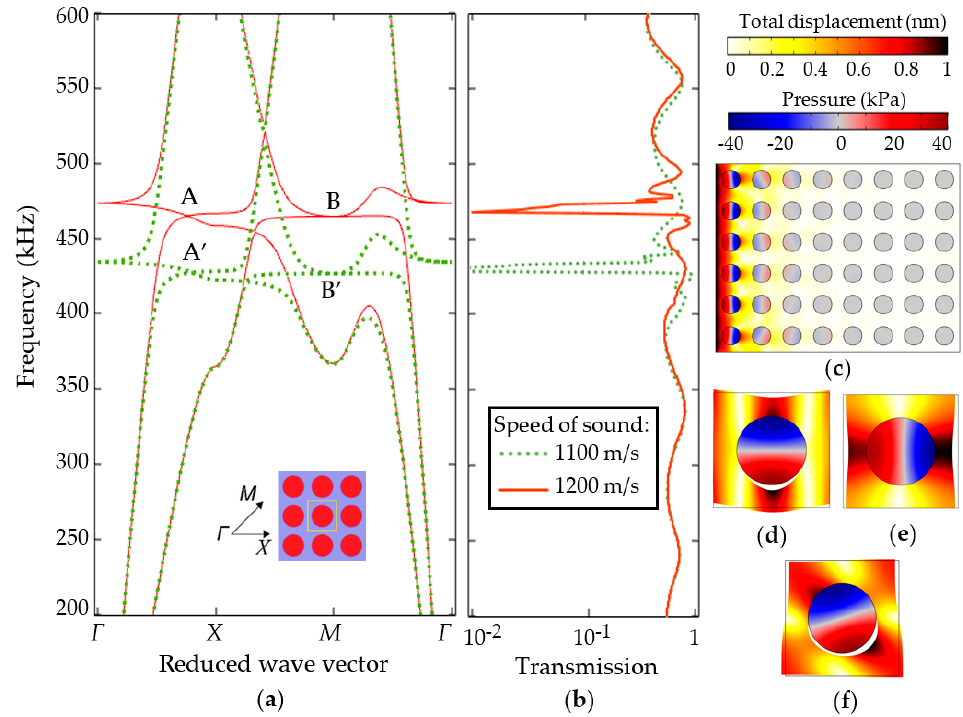
Figure 6. Theoretical description of the second type solid-liquid periodic composite sensor structure: ( a ) Band diagram for the 2D cubic infinite structure made of steel with periodic cylindrical liquid-filled holes computed for two different sound velocities in liquid (green dotted and red solid curves); ( b ) transmission spectrum of finite 2D solid-liquid composite structure with cubic symmetry for the same sound velocities; ( c ) displacement/pressure of the structure excited in the direction of wave propagation at the frequency corresponding to the transmission dip; ( d, e ) structure eigenmodes of solid-liquid composite unit cell corresponding to point A; ( f ) eigenmode of solid-liquid unit cell corresponding to point B. Total displacement and pressure distributions are shown by colors with white corresponding to the nodal lines or zero displacement.